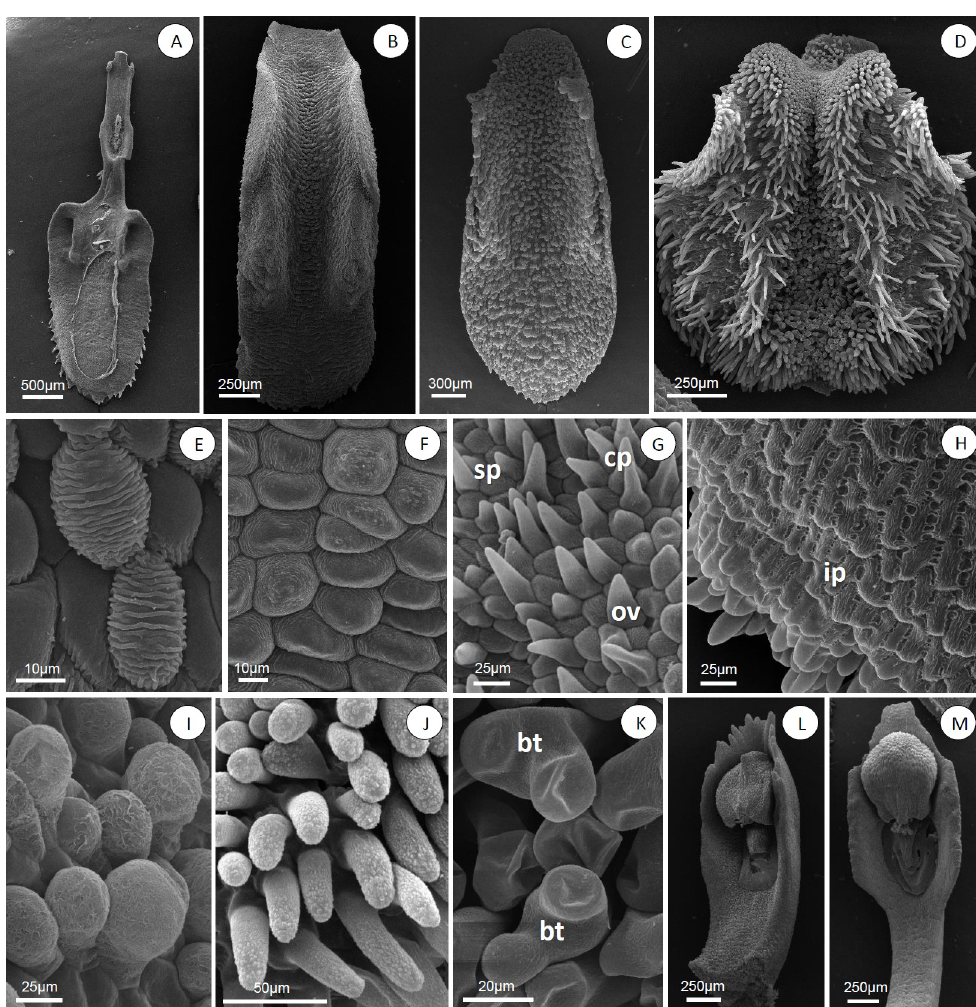
Fig 5. Acianthera and Pleurothallopsis nemorosa , labellum, general view (A-D), labellum micromorphology (E-K) and column, general view (L and M). (A) Acianthera hatschbachii . (B) Acianthera ochreata . (C) Acianthera prolifera . (D) Acianthera octophrys . (E) Acianthera octophrys , elongate polygonal cells with transverse striations. (F) Acianthera octophrys , irregular cells with concentric striations. (G) Pleurothallopsis nemorosa , simple (sp), conical (cp) and ovate papillae (ov). (H) Acianthera atropurpurea , imbricate papillae (ip). (I) Acianthera saundersiana , obpyriform papillae (op). (J) Acianthera octophrys , simple trichomes. (K) Acianthera octophrys bifurcate trichomes (bt). (L) Acianthera octophrys . (M) Acianthera ochreata